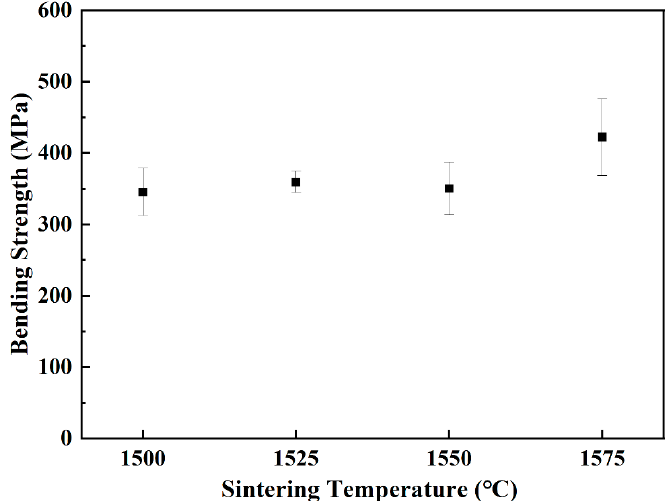
Figure 12. Bending strengths of sample A sintered at different temperature for 2 h.